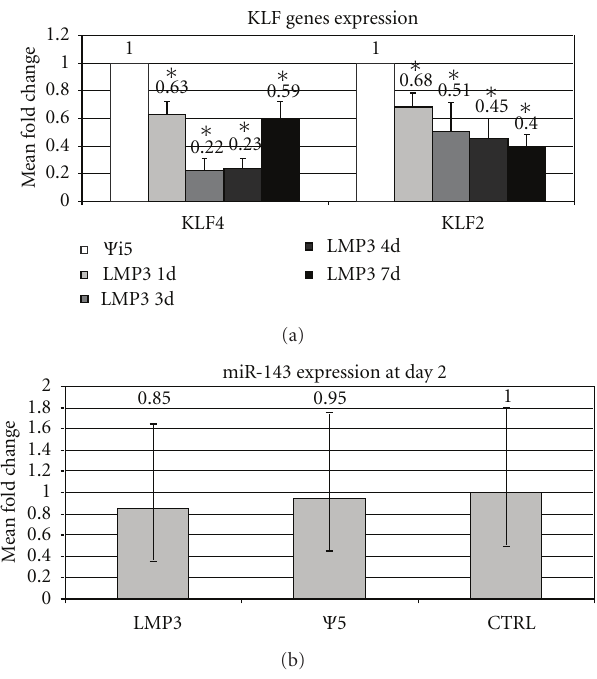
Figure 4: KLF genes expression analysis. Values represent the mean of triplicate experiments for each time point tested, namely, 2, 4, and 7 days after AdLMP3-mediated cell transduction; Ψ 5: control sample represented by mock-transduced cells. Fold change was calculated according to the 2 − ΔΔ Ct method. ∗ : statistical significance ( P < 0 . 05).